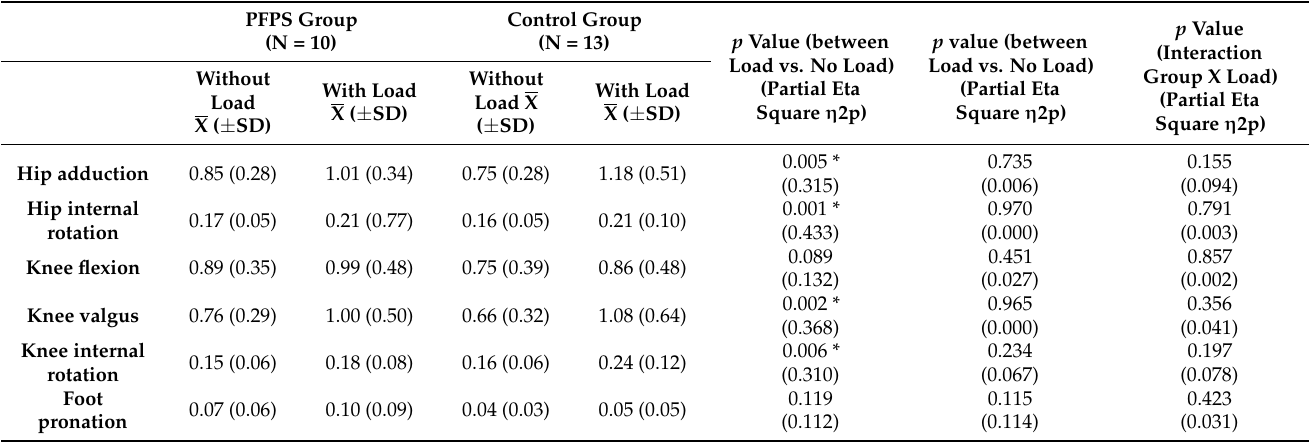
Table 4. Mean peak moments with and without load according to research groups and load condition (right leg, in Nm/BW).